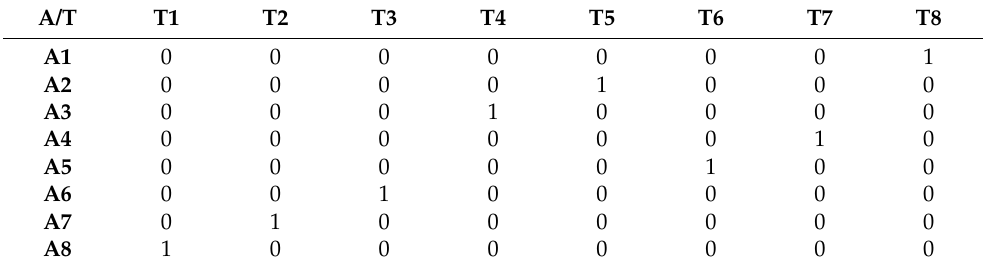
Table 6. Optimal assignments (expected efficiency maximization of the least efficient